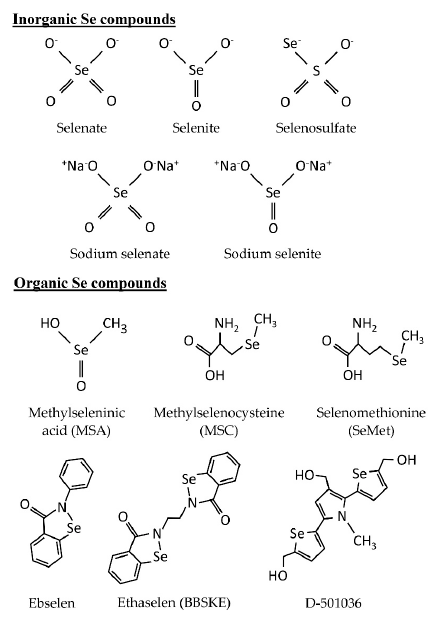
Figure 1. Chemical structures of selected representative inorganic and organic Se compounds discussed in this review.